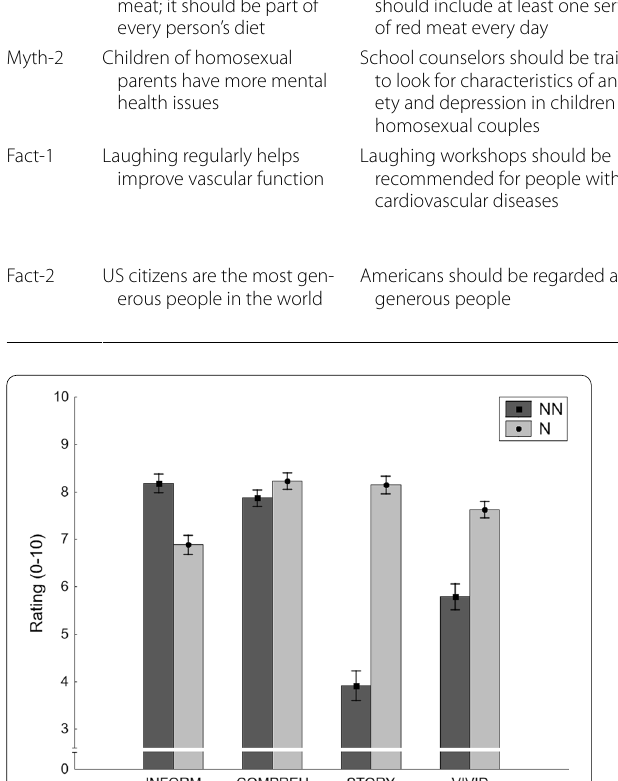
Fig. 8 Ratings of non-narrative (NN) and narrative (N) myth corrections on informativeness (INFORM), comprehensibility (COMPREH), story-ness (STORY), and vividness (VIVID) in the Experiment 3 Pilot. Error bars indicate within-subjects standard error of the